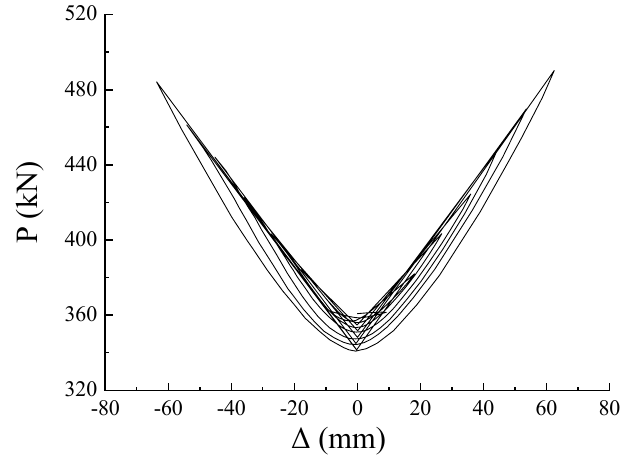
Figure 16. Prestressing force.